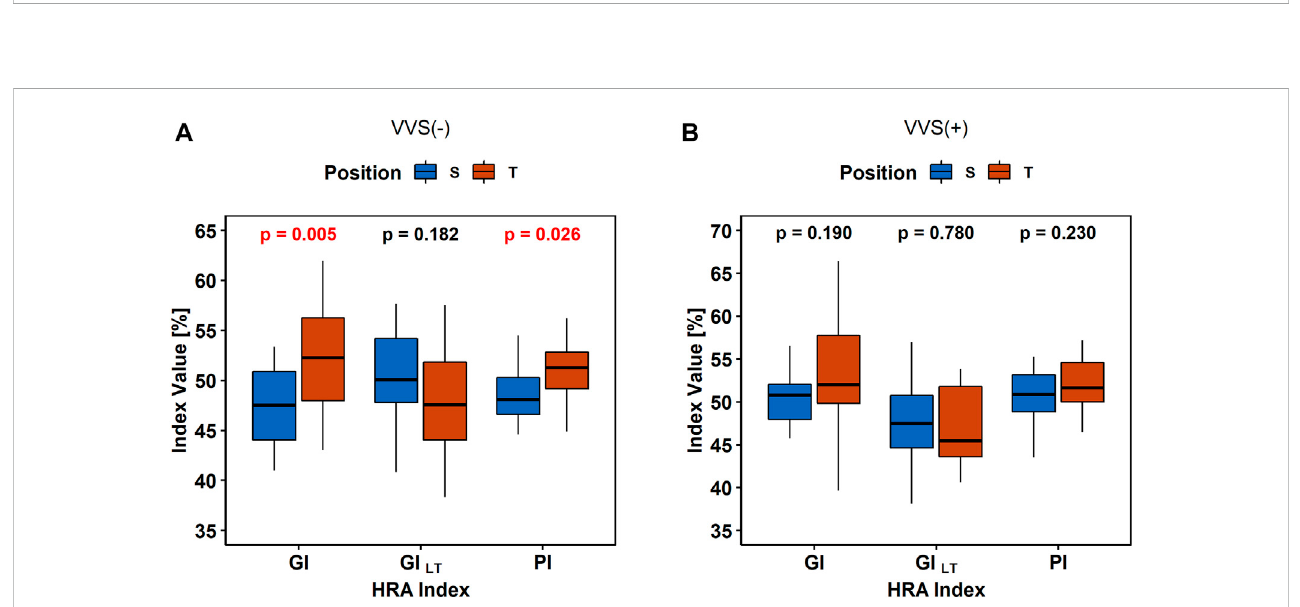
FIGURE 4 Comparison of heart rate asymmetry indices (Guzik ’ s Index, GI; Porta ’ s Index, PI; and slow-term Guzik ’ s Index, GI S ) between the supine (S) and tilt (T) phases of the tilt test in the control group (A) and in vasovagal patients (B) .